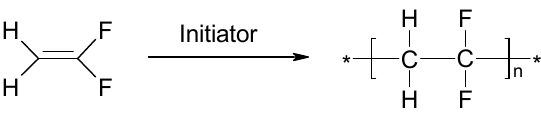
Figure 5. The polymerization of